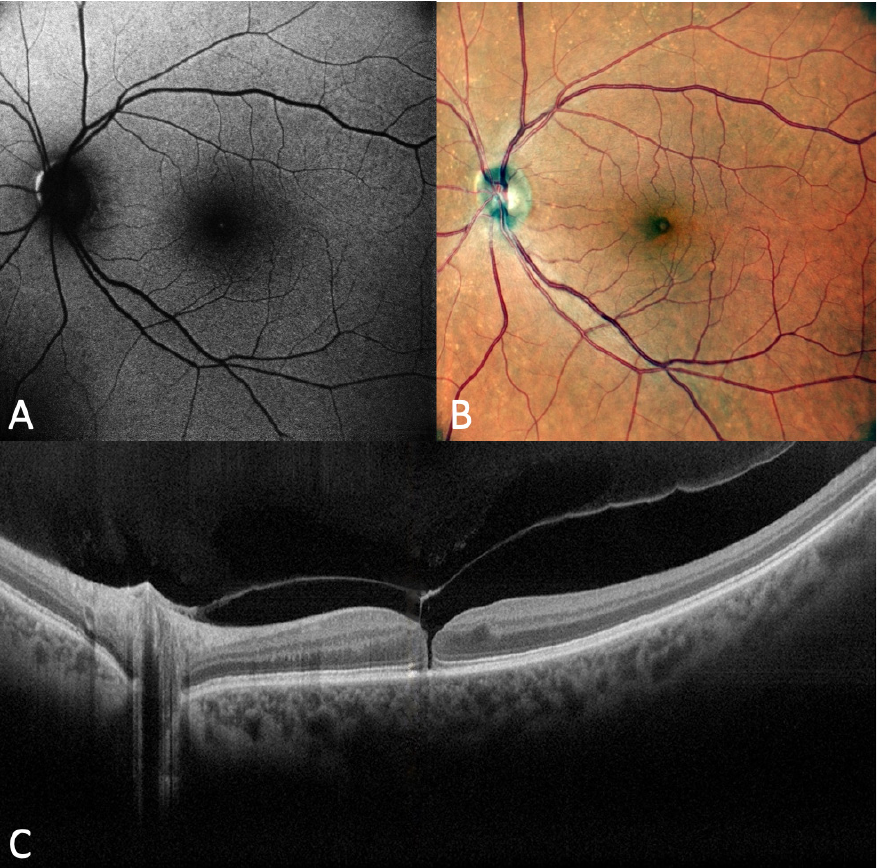
Figure 9. ( A ) Fundus autofluorescence (FAF) image of a small full-thickness macular hole. FAF shows a very low hyperautofluorescence in the macula. ( B ) Fundus photograph in the same eye. ( C ) Optical coherence tomography scan in the same